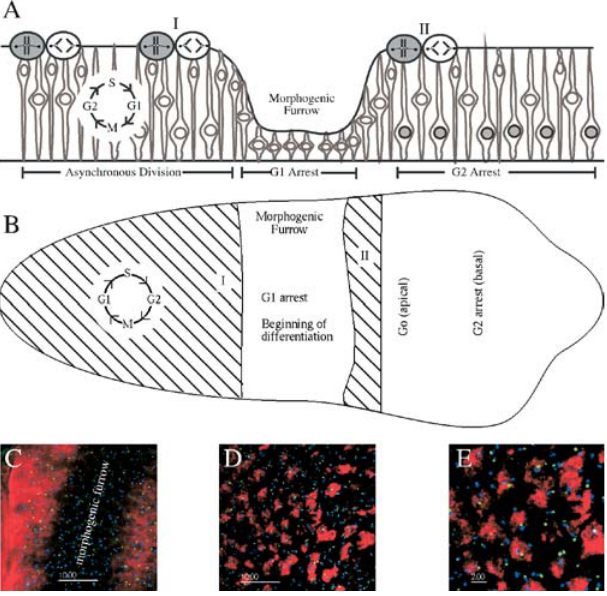
Figure 5. Identification of Cell Cycle Stages in Drosophila Eye Disks A combination of immunofluorescence to cyclins and tissue architecture was used to identify cells in specific cell cycle states. (A) Cartoon of eye disk that shows populations of dividing and cell- cycle-arrested cells. I, first mitotic wave; II, second mitotic wave. G2- arrested cells are filled nuclei located basally posterior to the furrow. (B) Cartoon of same disk viewed from above apical side of disk. Anterior is to the left. (C–E) Immunofluorescence against G2 cyclins identifies cells in G1 and G2 arrest. Red is anti–cyclin A, green is single-copy FISH signal, and blue is heterochromatic FISH signal. (C) G1-arrested cells can be identified as those near and in the morphogenic furrow that do not show G2 cyclin staining. (D) G2-arrested cells posterior to the morphogenic furrow show dense anti–cyclin A staining. (E) Close-up of cells shown in (D). DOI: